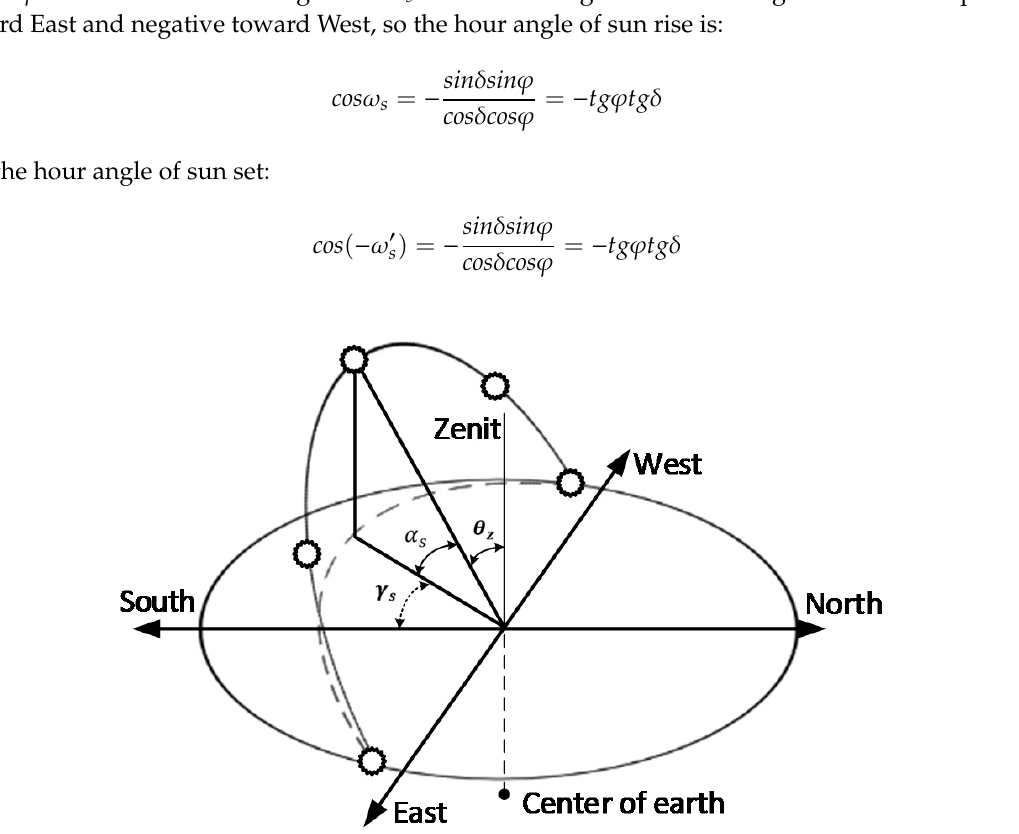
Figure 1. Daily path of the sun from sunrise to sunset.